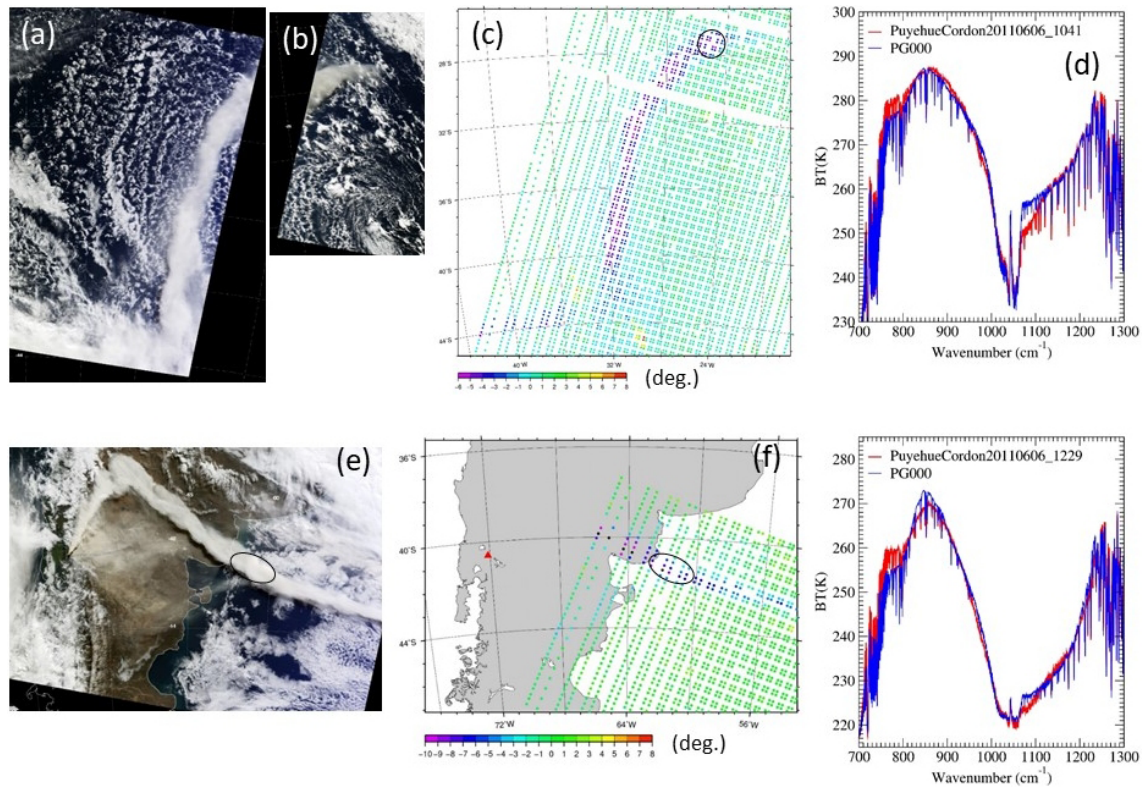
Figure 16. (a–c) MODIS true-color images at (a) 12:45UTC and (b) 11:05UTC, and (c) IASI (cid:49) BT split at 10:41–10:47UTC for Puyehue- Cordón Caulle ash plumes on 6 June 2011. (d) Results of BTS simulation with the PG000 RI model for the pixel at (lat, long) = (27136 ◦ S, 25178 ◦ W). (e–g) MODIS image at (e) 14:25UTC, and (f) IASI (cid:49) BT split at 12:29UTC. (g) Results of BTS simulation for the pixel at (lat, long) = (41.212 ◦ S, 61.898 ◦